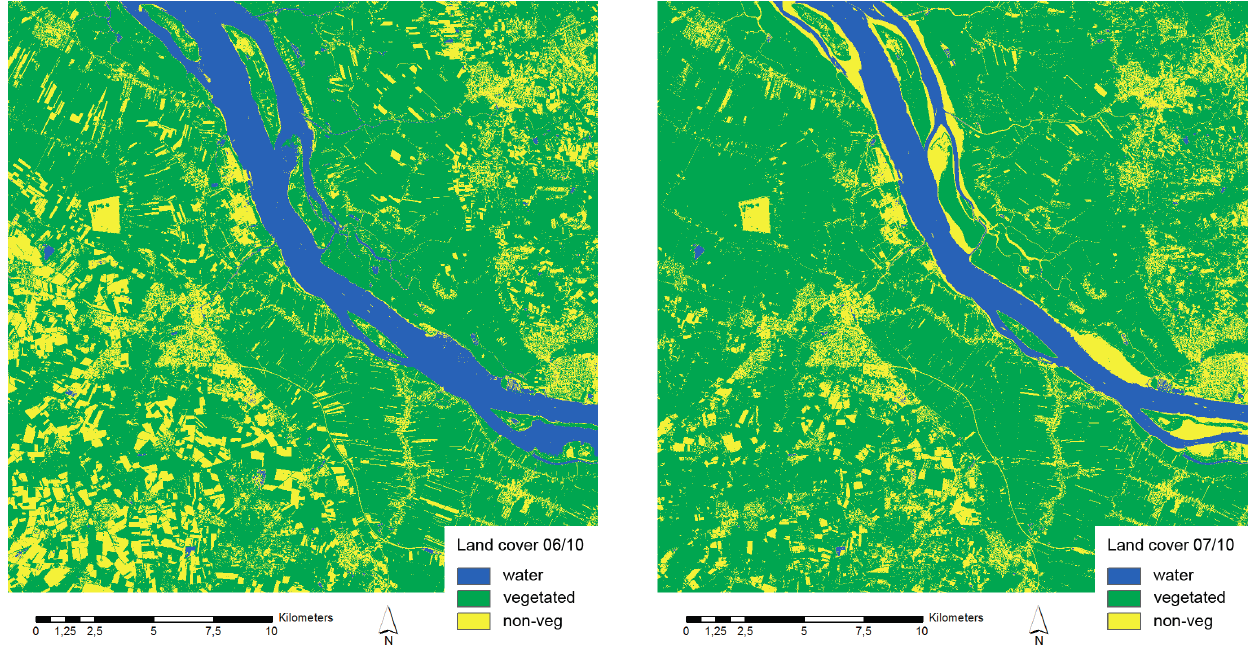
Figure 6. The two classified datasets from RapidEye imagery we used in this case